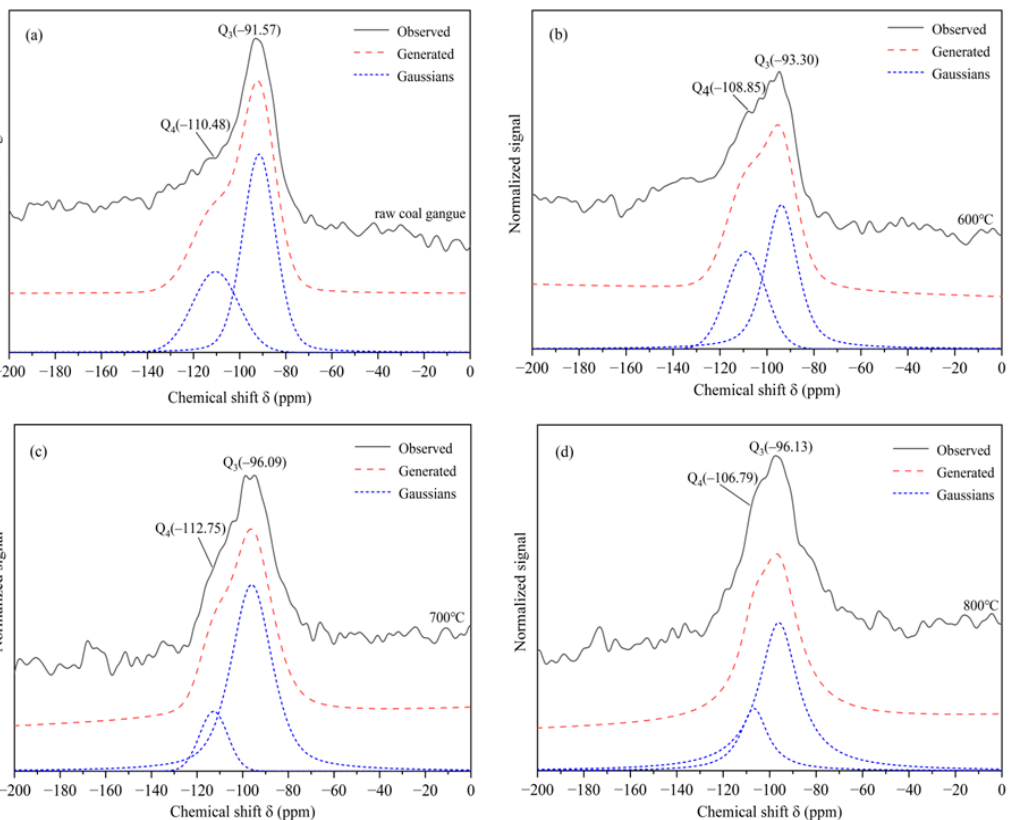
Figure 6. 29 Si NMR of the CG sample after calcination at different temperatures ( a ) un-calcined CG sample, ( b ) CG sample calcined at 600 °C, ( c ) CG sample calcined at 700 °C, and ( d ) CG sample calcined at 800 °C.